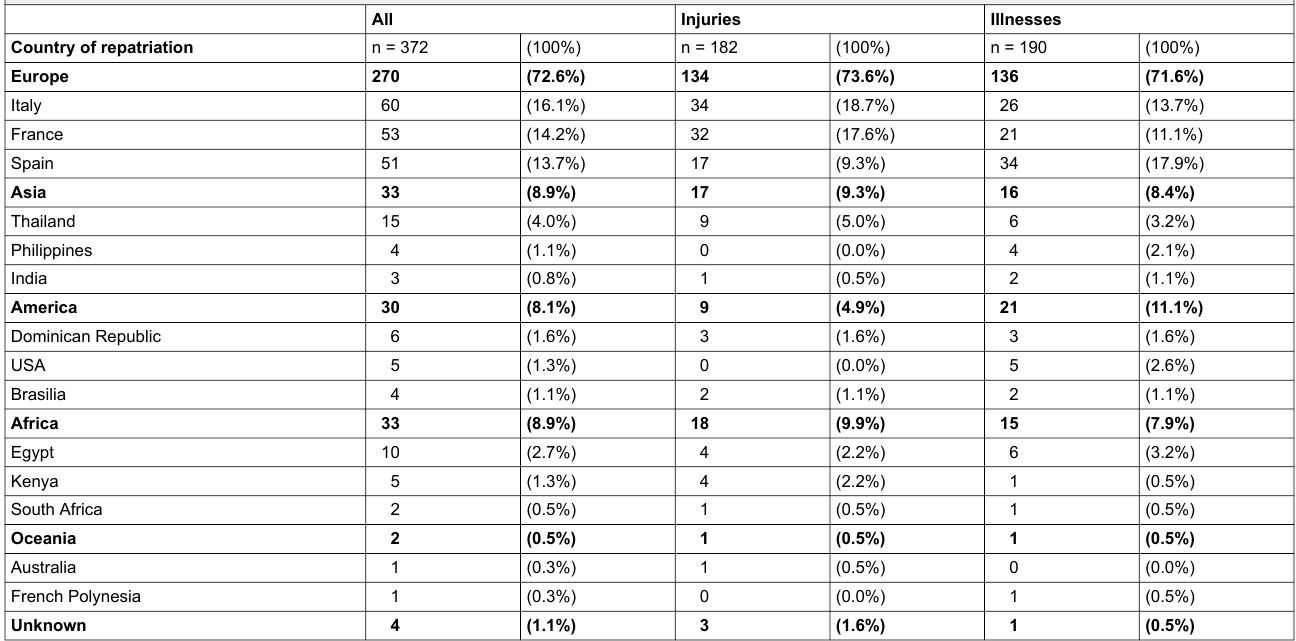
Table 3: Continents and countries from which patients were repatriated.